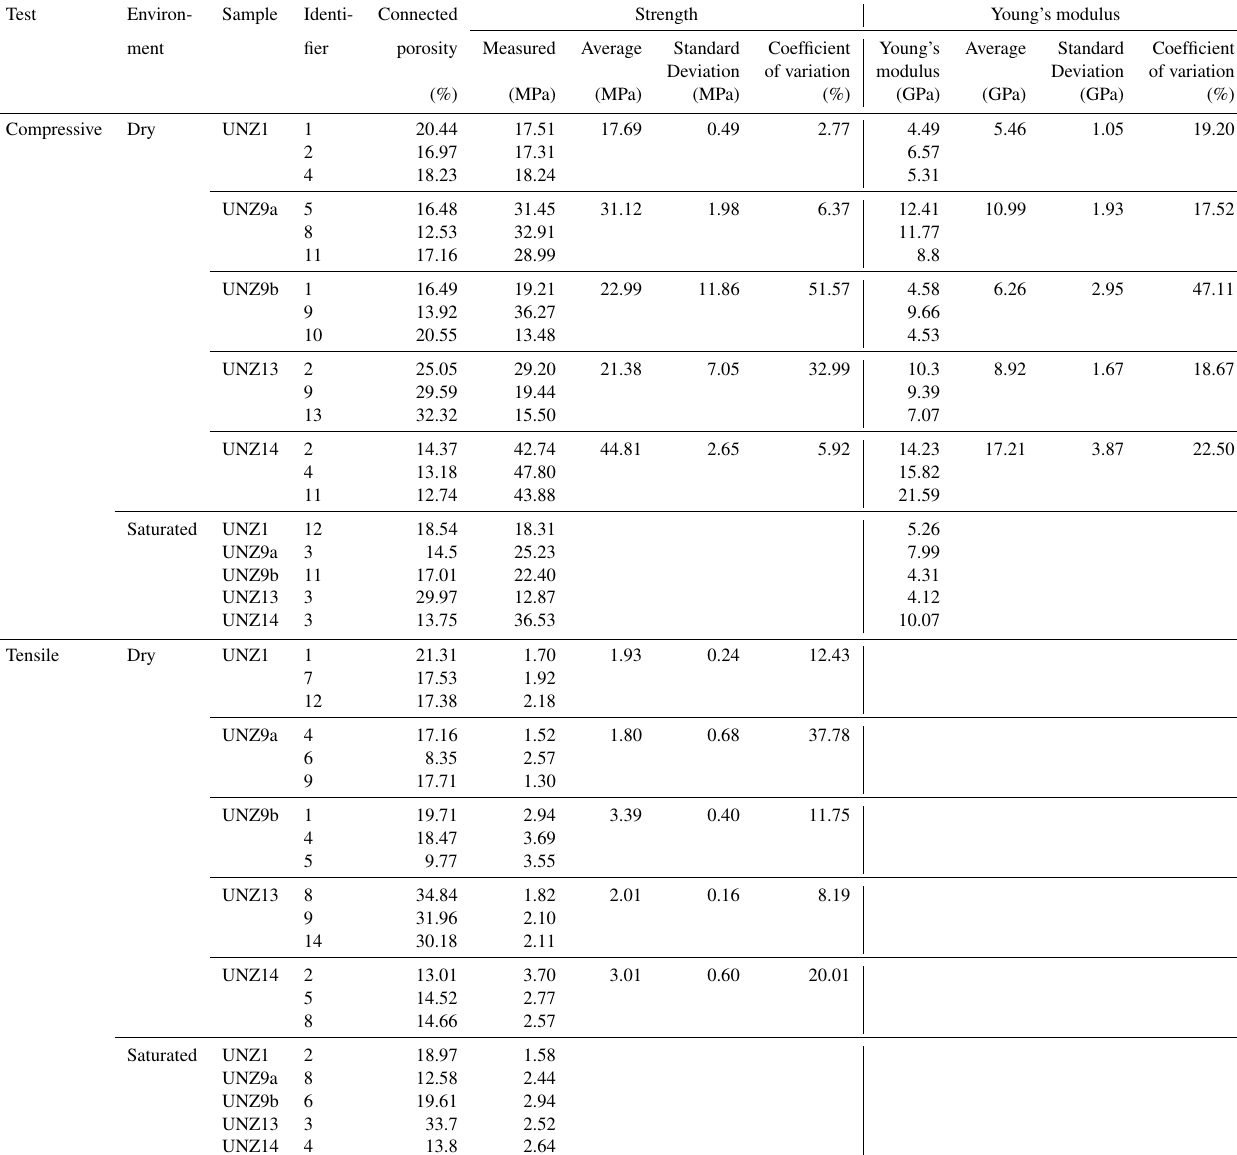
Table 4. Sample mechanical properties under dry and saturated conditions. Test Environ- Sample Identi- Connected Strength